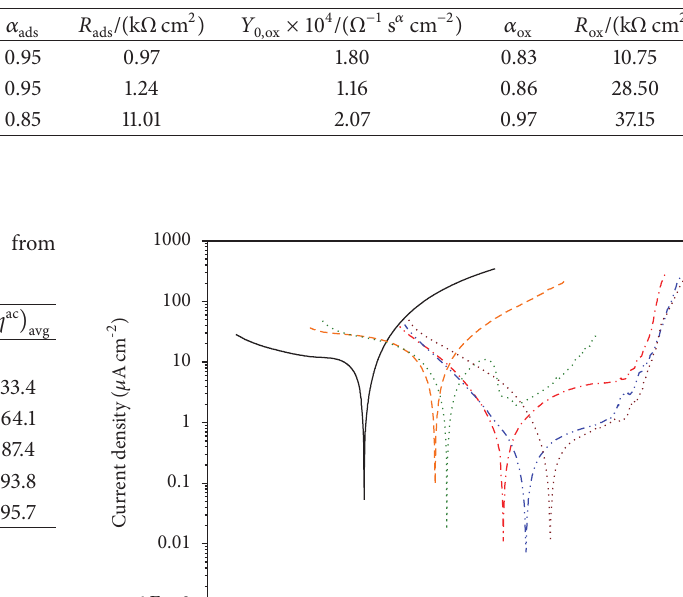
Table 2: Parameters from equivalent circuit analysis of typical impedance data obtained in solutions containing glutarate with concentrations ≥ 32 mM.